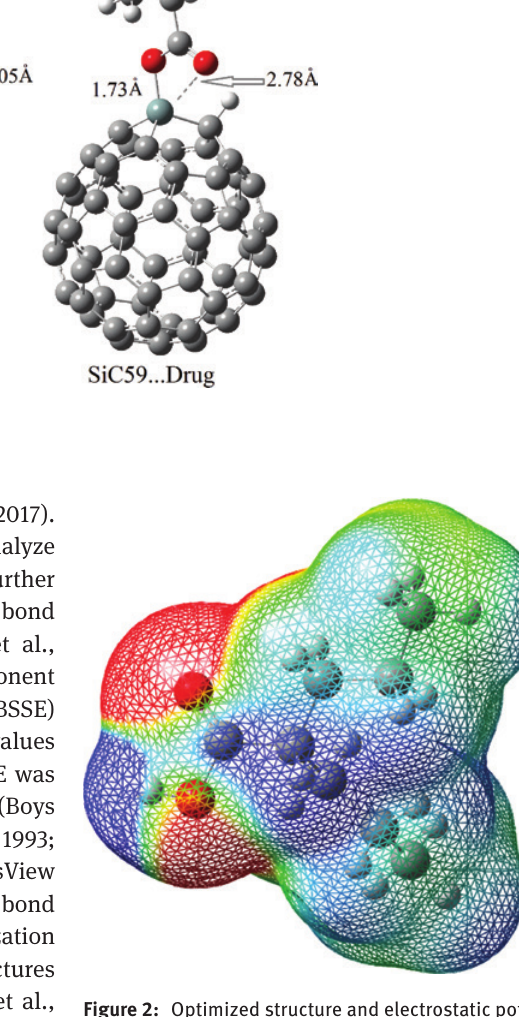
Figure 2: Optimized structure and electrostatic potentials of VPA. Color ranges (in a.u.): blue, more positive than 0.01; red, more nega- tive than –0.01.